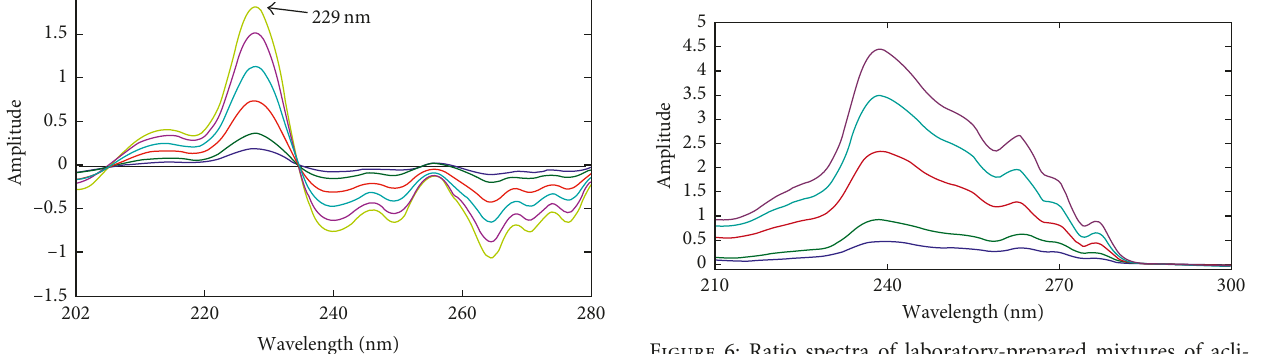
Figure 4: First derivative of the ratio spectra of aclidinium at various concentrations (5–50 µ g/mL) using 8 µ g/mL of formoterol as a divisor.